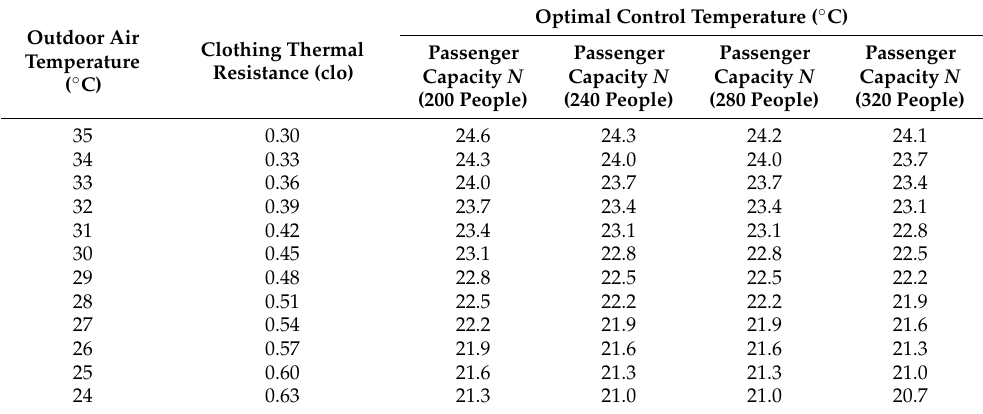
Table 9. The optimal control temperature considering the temperature difference between the return air and the comfort section around people.